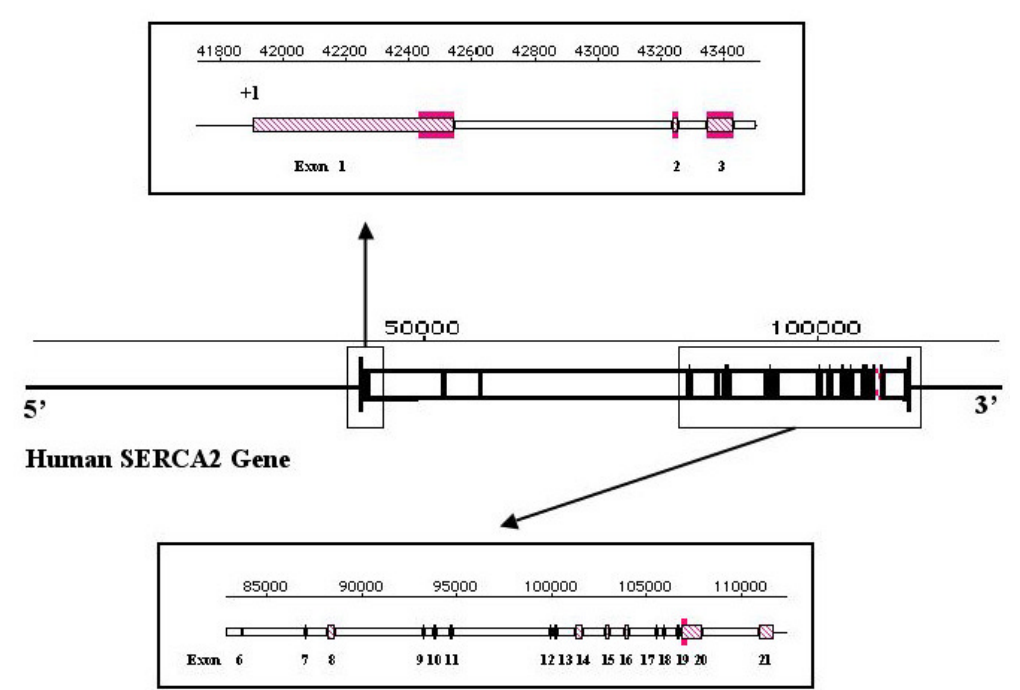
FIGURE 2. Genomic structure of the human SERCA2 gene. Schematic representation of the SERCA2 gene in clone RPC 13-305I20 is shown. The upper box shows the location of exons of the 5’-end region of the gene. Translated region is indicated with gray bars. The lower box indicates the position of exons 6 to